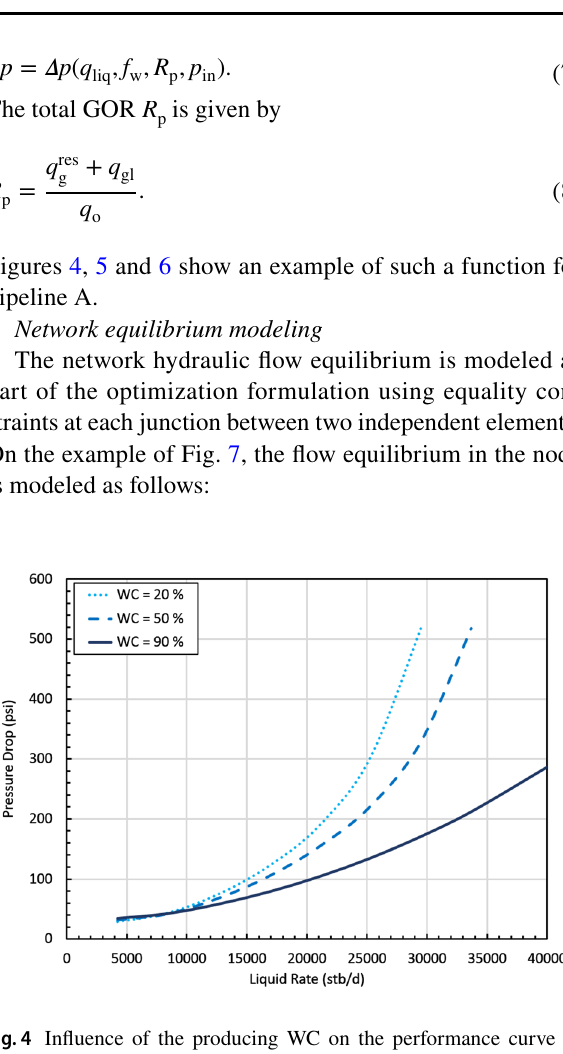
Fig. 4 Influence of the producing WC on the performance curve of pipeline A. The GOR is held constant and equal to 700 scf/stb and the inlet pressure is equal to 700 psia